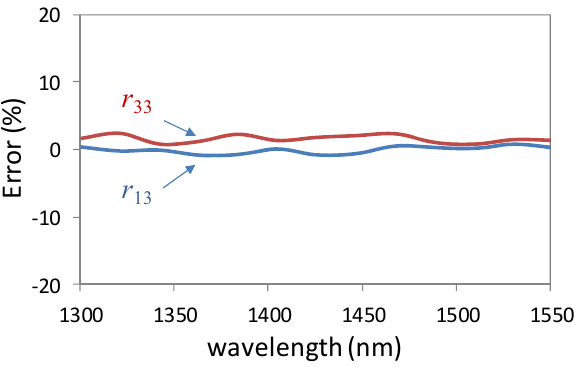
Figure 4. Simulated errors of r calculated angular shift of the reflection